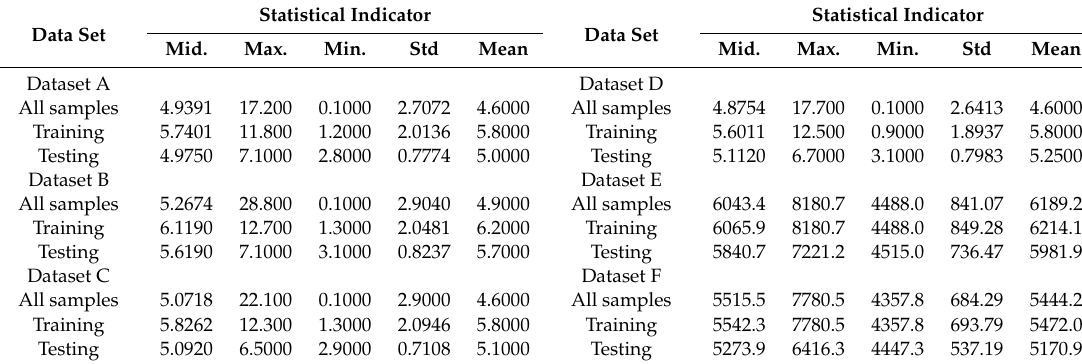
Figure 6. Four wind speed datasets with 10-min time intervals. Table 3. Statistical values of each experiment